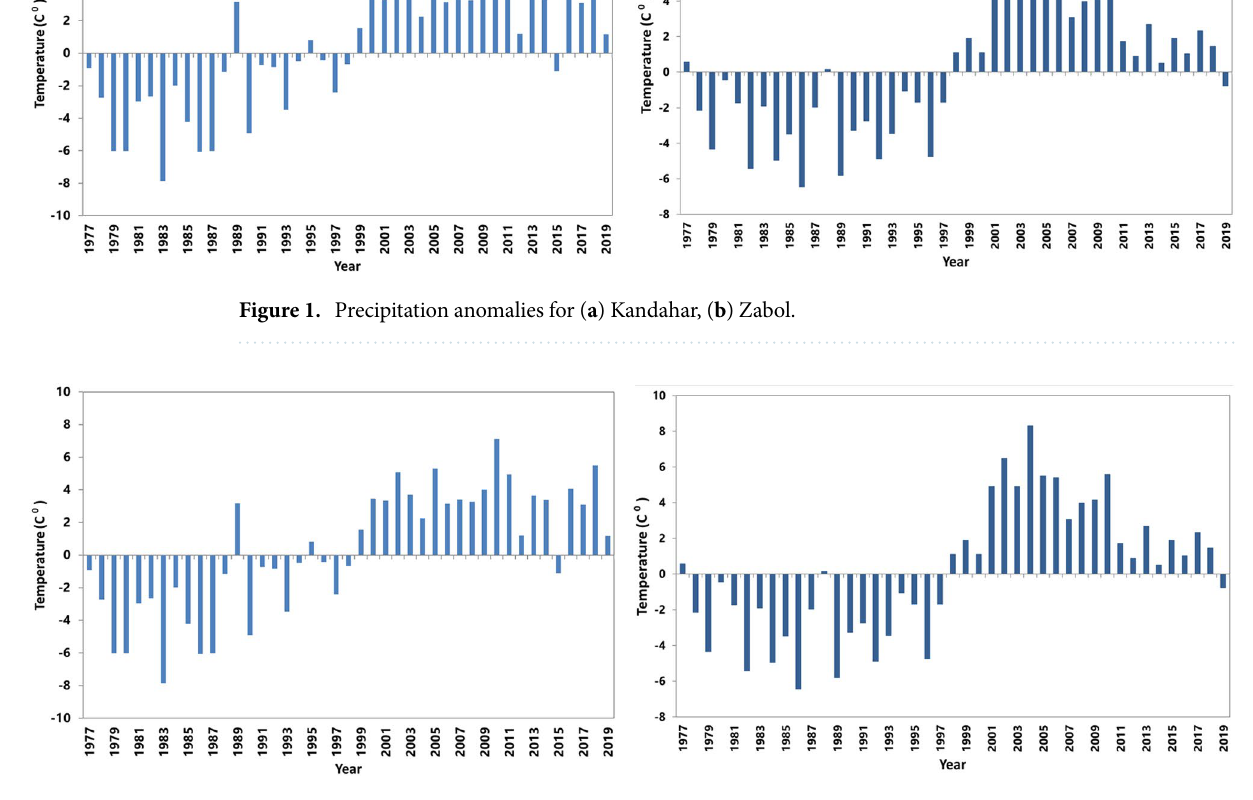
Figure 2. Mean annual temperature anomalies for ( a ) Kandahar, ( b )